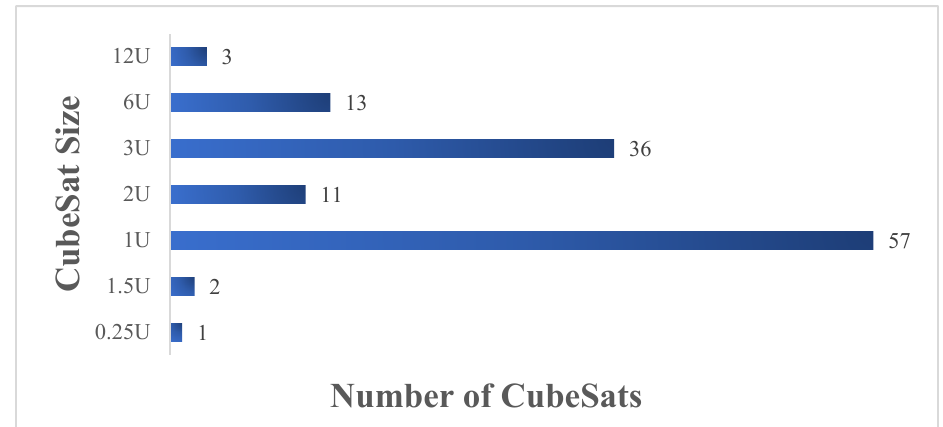
Figure 3. Popularity of CubeSat mission types from 2003 to 2022.